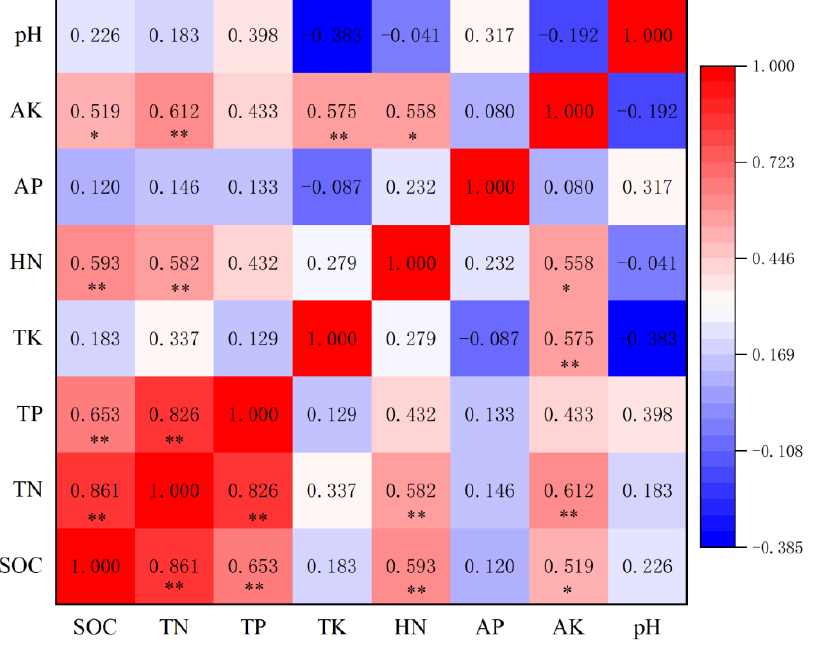
Figure 6. Pearson’s correlation heatmap of bulk soil nutrient concentrations and pH: * Significant at p < 0.05; ** significant at p < 0.01.